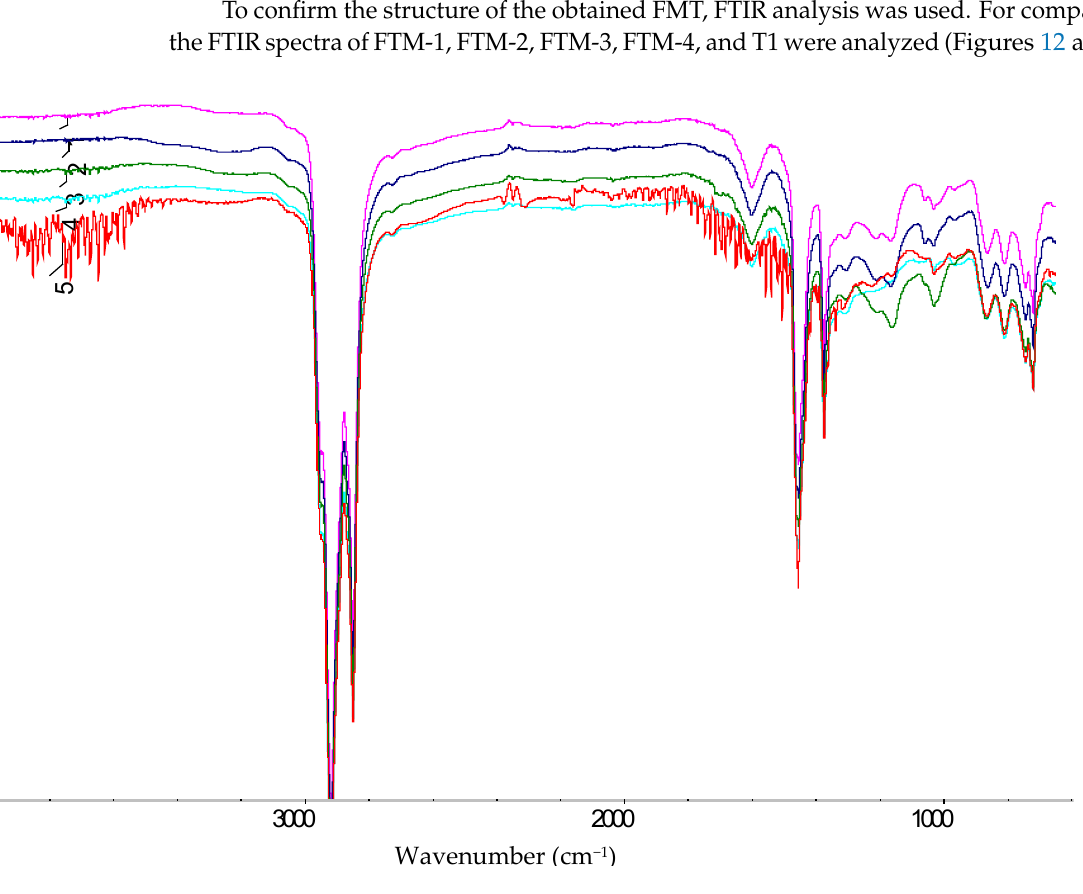
Figure 12. FTIR spectrum (4000 – 600 cm −1 ): 1 —FTM -1; 2 —FTM -2; 3 —FTM -3; 4 —FTM -4; 5 — Т1.